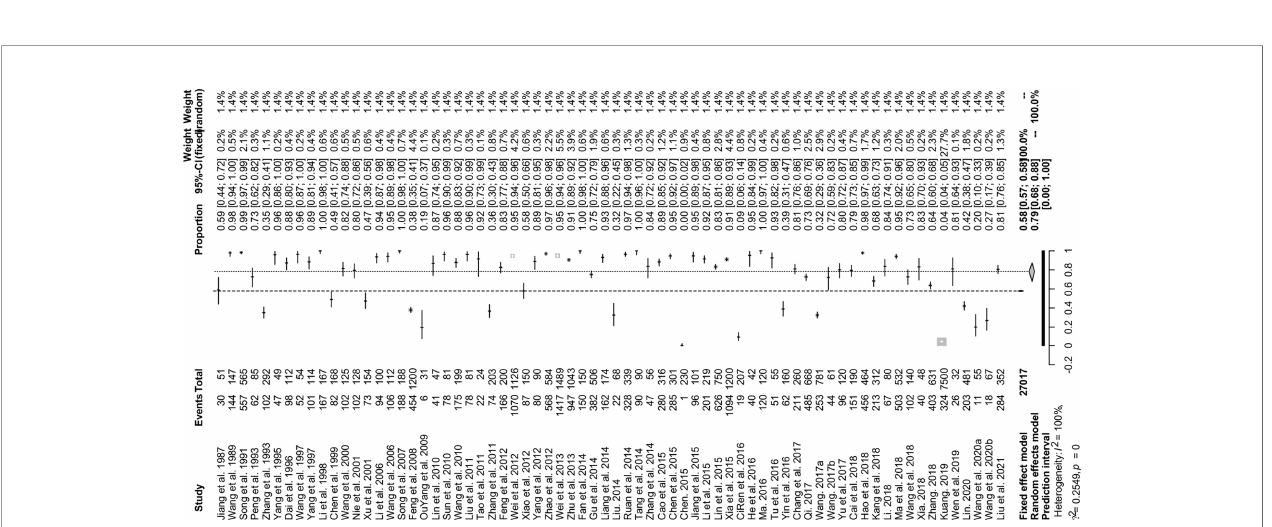
FIGURE 2 | Forest plot of prevalence of Eimeria spp. in goats amongst studies conducted in China. The length of the horizontal line represents the 95% CI; the diamond represents the summarized effect.